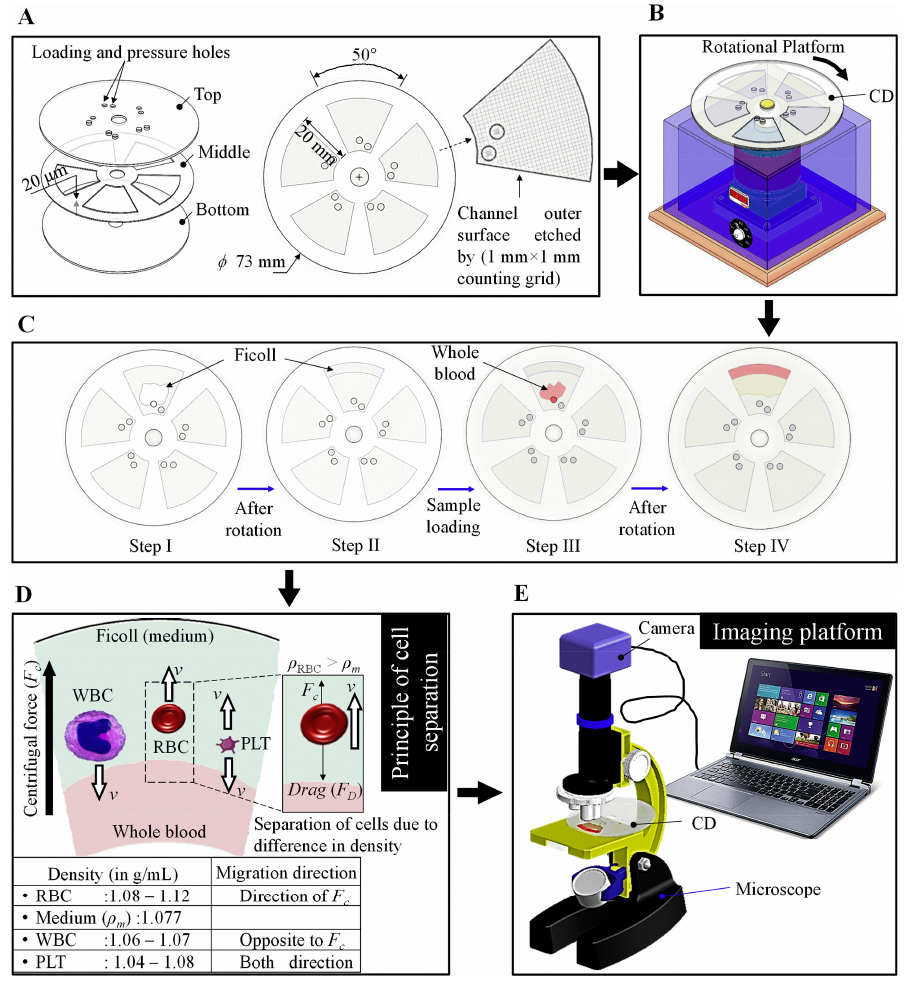
Figure 6. Representation of the experimental process. ( A ) Design specifications of the compact disc, with etched grid for cell counting. ( B ) Spinning platform. ( C ) Stepwise procedure of sample pro- cessing in the disc. ( D ) Illustration of the principle of cell separation; transport of cellular compo- nents of blood under competing effects of rotational force (centrifugal force), buoyancy force, and